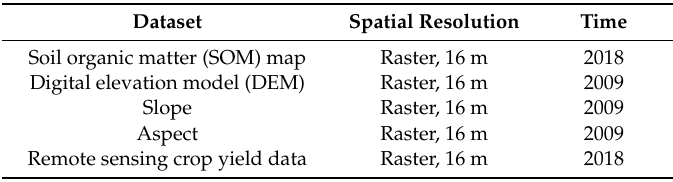
Table 2. The dataset characteristics of the tested